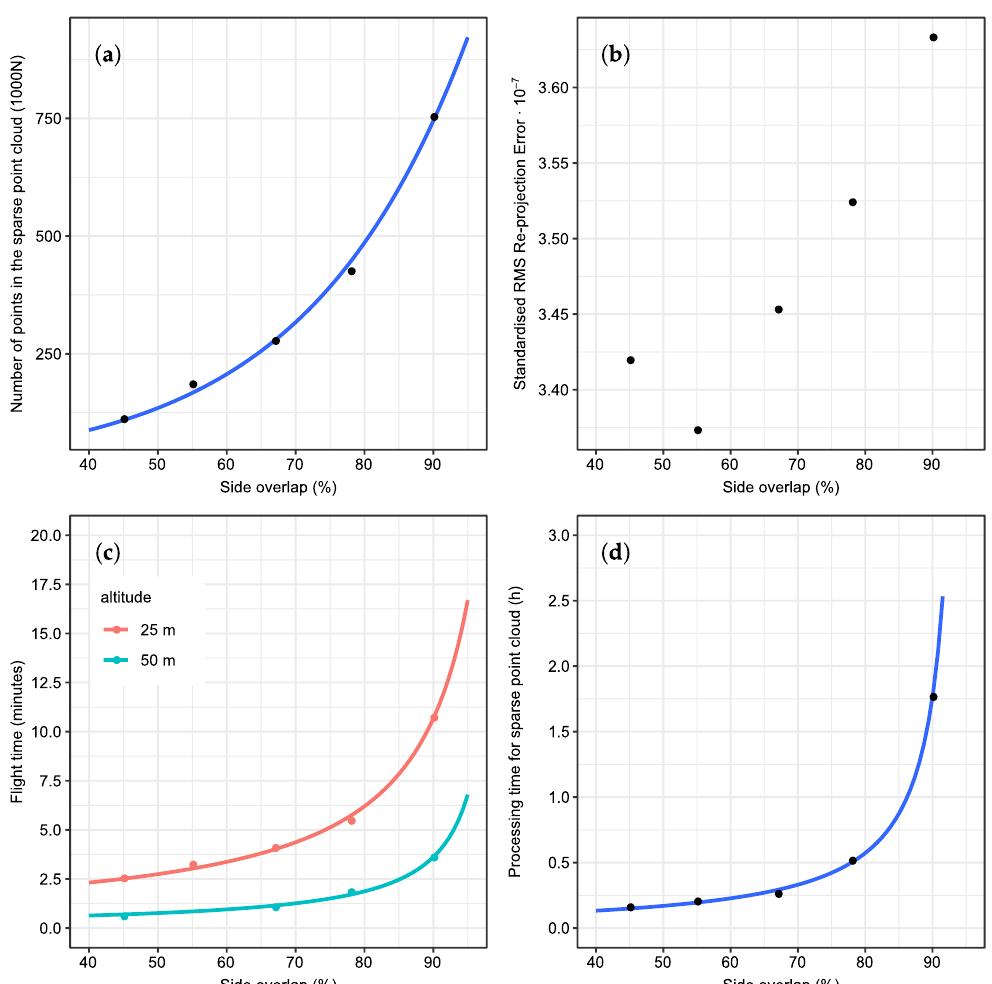
Figure 6. Relationships between side overlap and ( a ) tie point numbers, ( b ) the SRMSRE, ( c ) the flight time, ( d ) the processing time for the sparse reconstruction. Equation and regression coefficients are in Supplementary Table